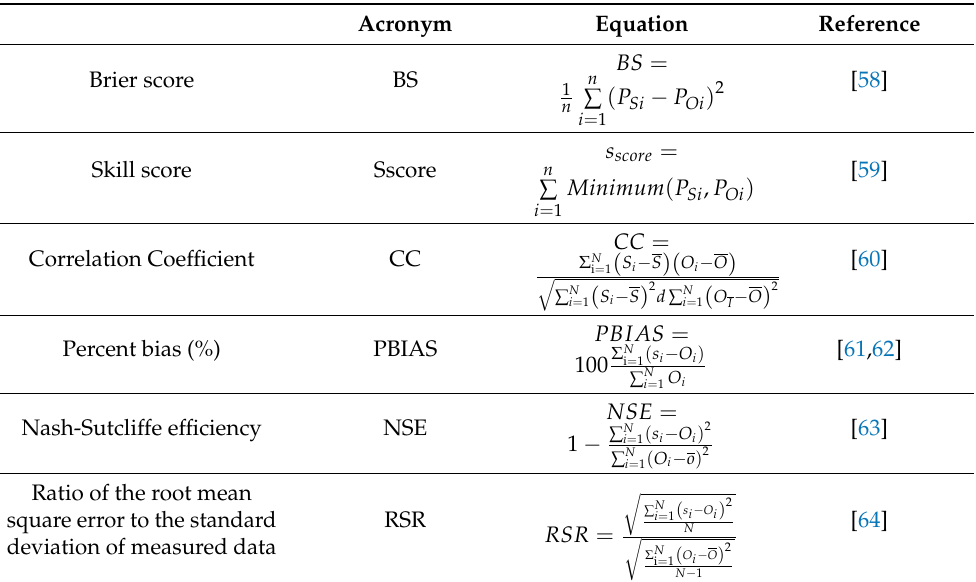
Table 1. Definitions and equations of the statistical